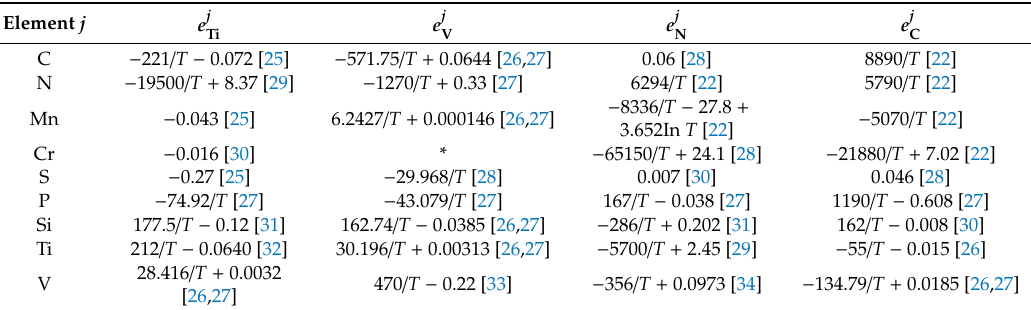
used in the present i